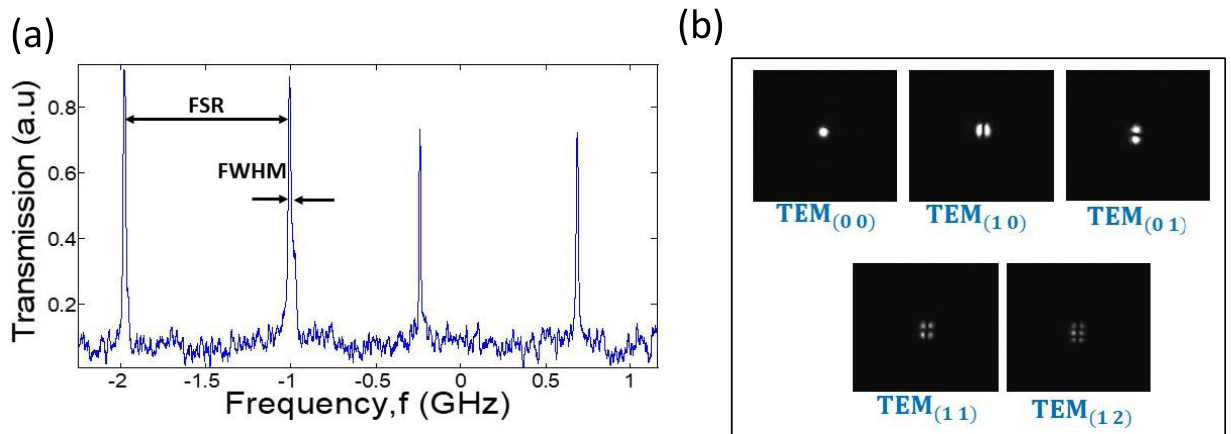
Figure 4. Resonator characterization. ( a ) Spectral distribution of the optical mode. ( b ) Spatial mode profile along the direction transverse to the light propagation direction. The viscosity is 60,000 cSt.